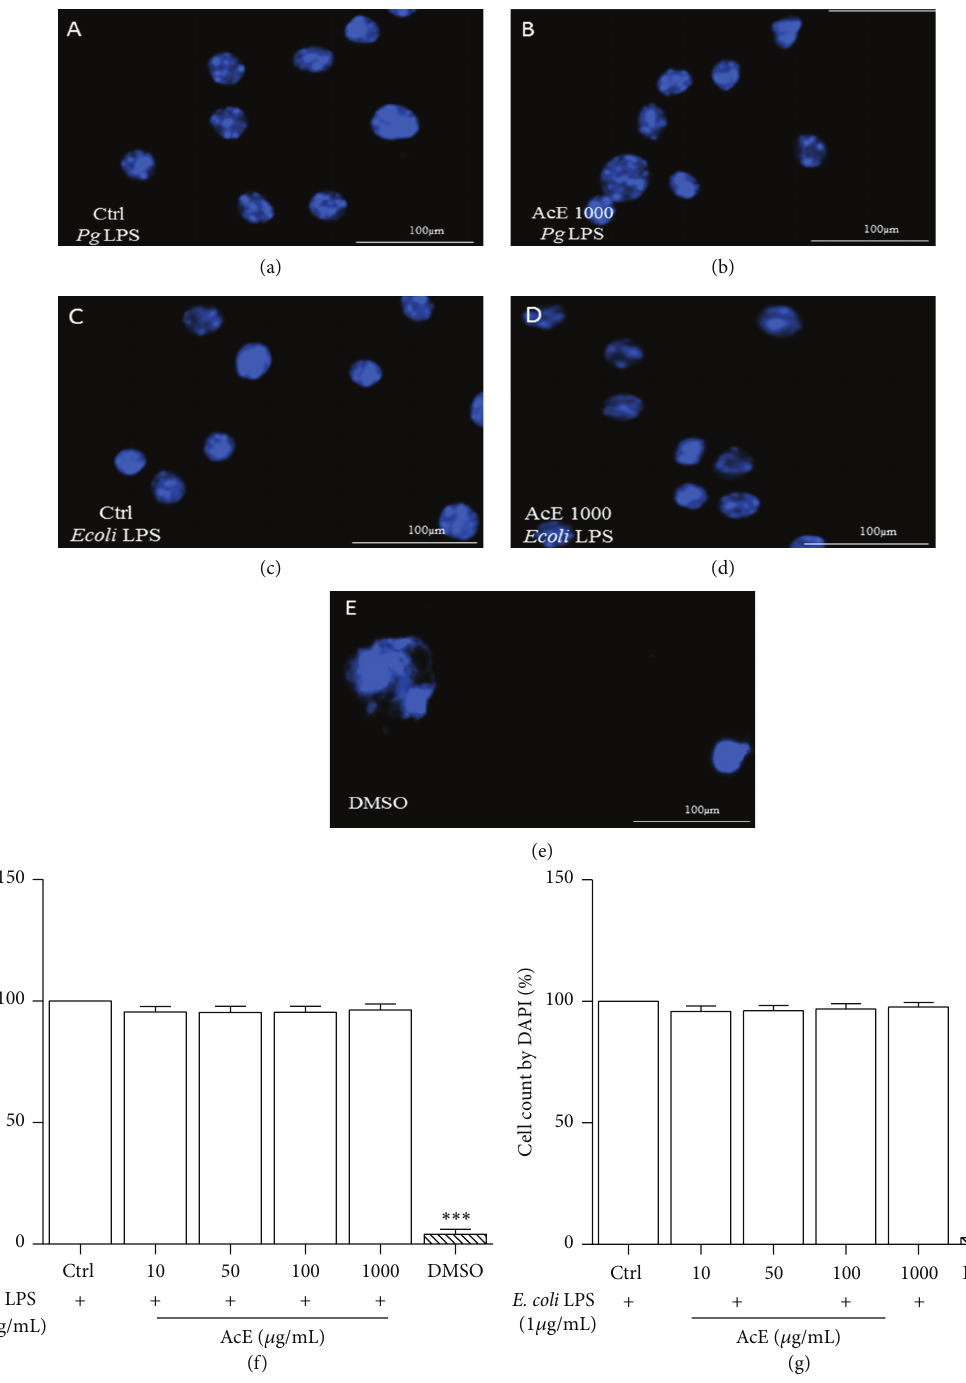
Figure 4: Effect of Allium cepa L. on cell morphology and cell count by DAPI on LPS-induced RAW 264.7 cells. RAW cells were cultured in the presence of Pg LPS ((a), (b), and (f)) or E. coli LPS ((c), (d), and (g)), and AcE; untreated cells (Ctrl) were not exposed to AcE. In (a) (Ctrl Pg LPS) and (b) (AcE 1000 𝜇 g/mL); (c) (Ctrl E. coli LPS) and (d) (AcE 1000 𝜇 g/mL) morphology was observed. DMSO was used for positive control (e). In (f) and (g), cell count by DAPI staining using a fluorescence microscope. Columns represent the mean values of the results obtained of three independent experiments. There was no significance between control (Ctrl) and cells in all concentrations tested,